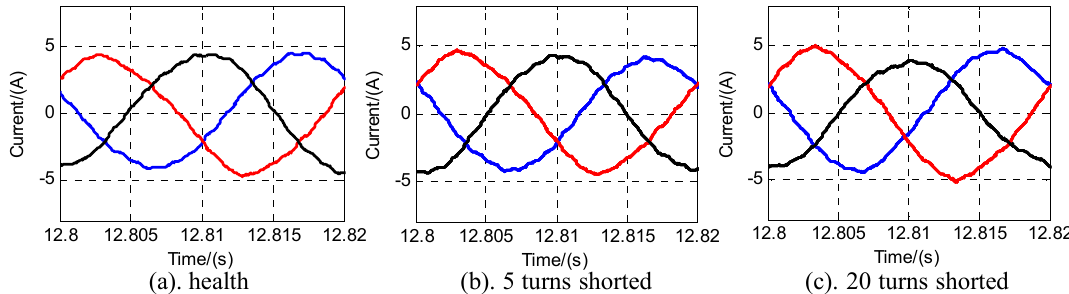
ff erent shorting turns with R